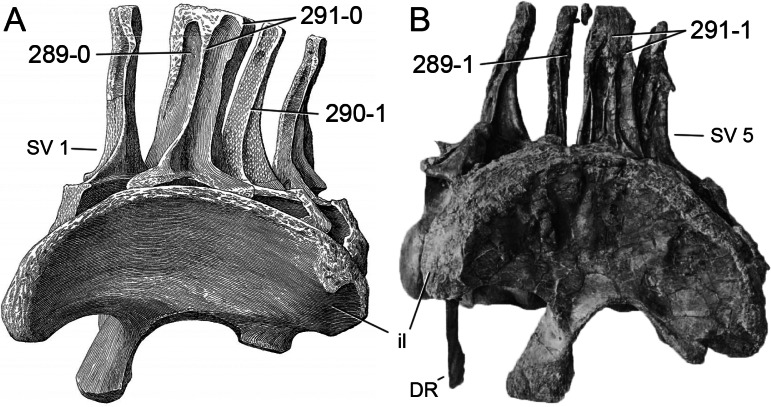
Diplodocid sacra.Sacra of Brontosaurus parvus UW 15556 (A; modified from Hatcher, 1903) and Diplodocus hallorum AMNH 223 (B; modified from Osborn, 1899) in left lateral view. Note the flat (A; C289-0) instead of ornamented sacral neural spine top (B; C289-1), the spdl that extends ventrally to the diapophysis (A; C290-1), and the parallel (A; C291-0) in contrast to converging neural spines (B; C291-1). Abb.: DR, dorsal rib; il, ilium; SV, sacral vertebra. Scaled to the same height.